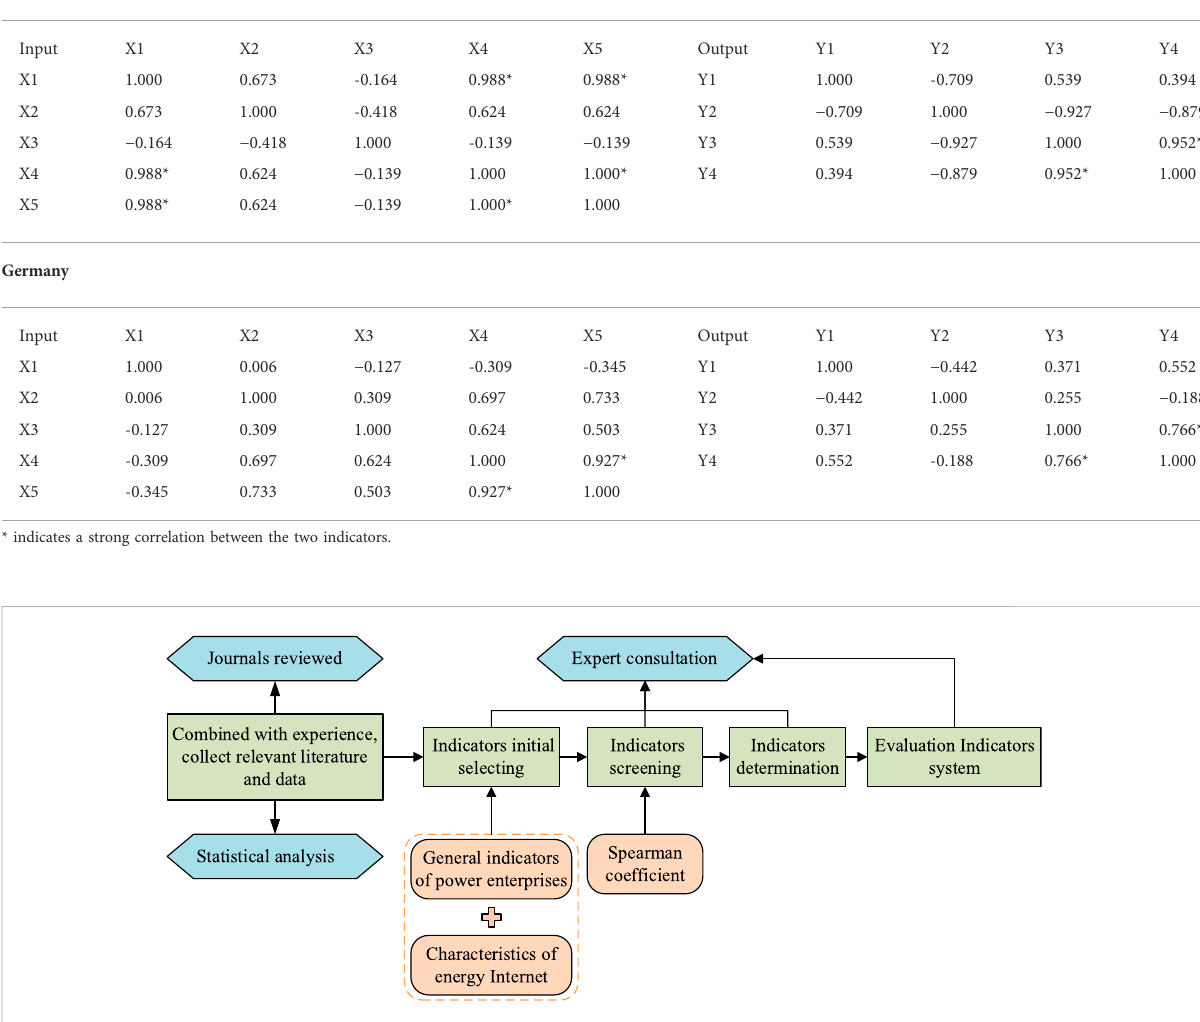
FIGURE 1 The determination process of evaluation indicators for investment and merger of energy Internet